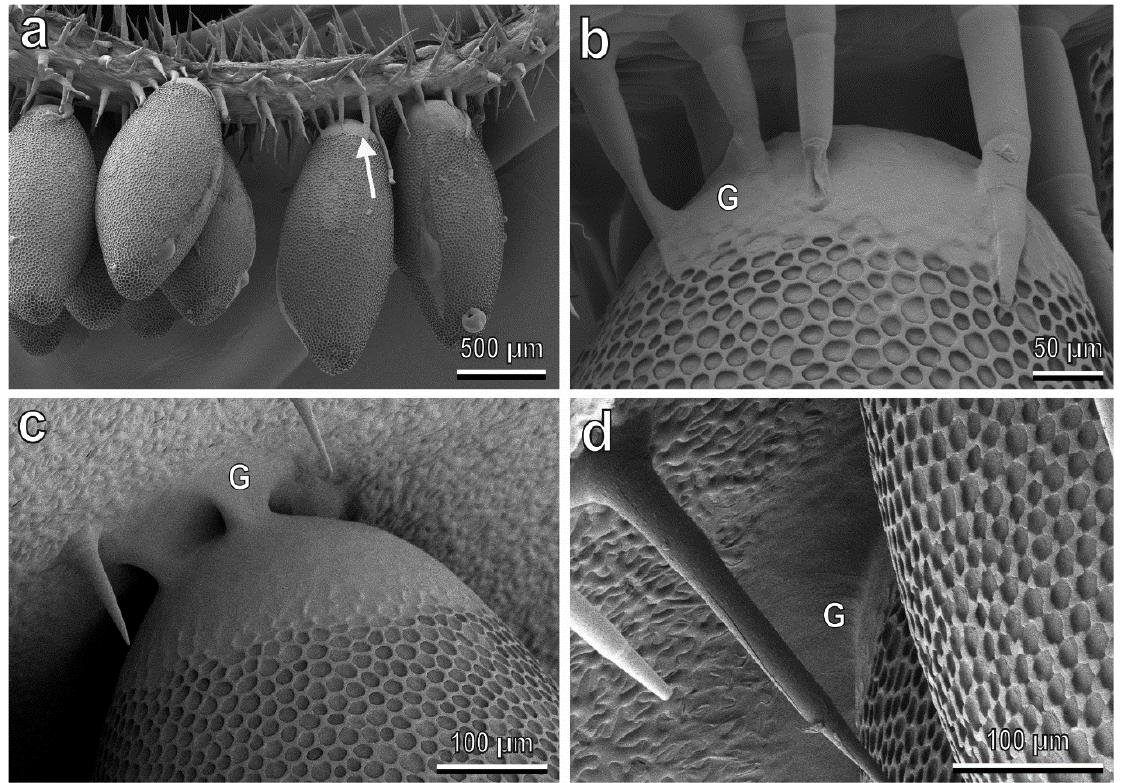
Figure 9. Chnootriba elaterii eggs laid on the abaxial side of Lagenaria siceraria ( a , b ) and Cucumis sa- tivus ( c , d ) leaves, cryo-SEM. ( a , b ) Densely situated trichomes (arrow) do not allow the egg glue (G) to reach the leaf surface. ( c , d ) The egg glue (G) adheres well to the leaf surface, thus replicating the leaf surface microsculpture.